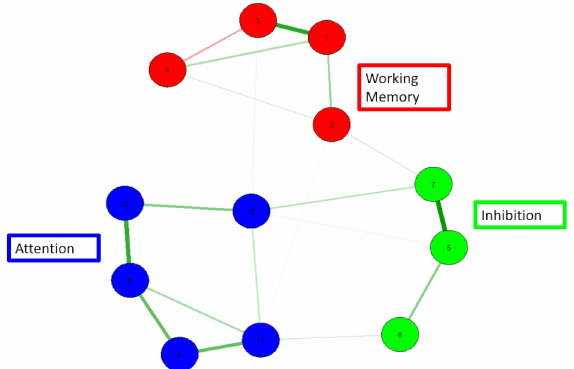
Figure 3. A network model of working memory, attention, and inhibition. 1 = verbal WM, 2 = symbolic WM, 3= digit span, 4 = picture span, 5 = full inhibition, 6 = auditory inhibition, 7 = visual inhibition, 8 = general attention, 9 = auditory attention, 10 = visual attention, 11 = auditory sustained attention, and 12 = visual sustained attention. Red = WM; green = inhibition; blue =